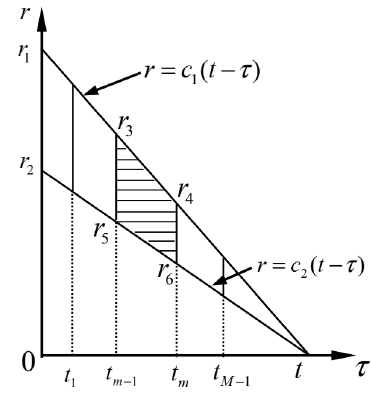
Figure 2. Division of